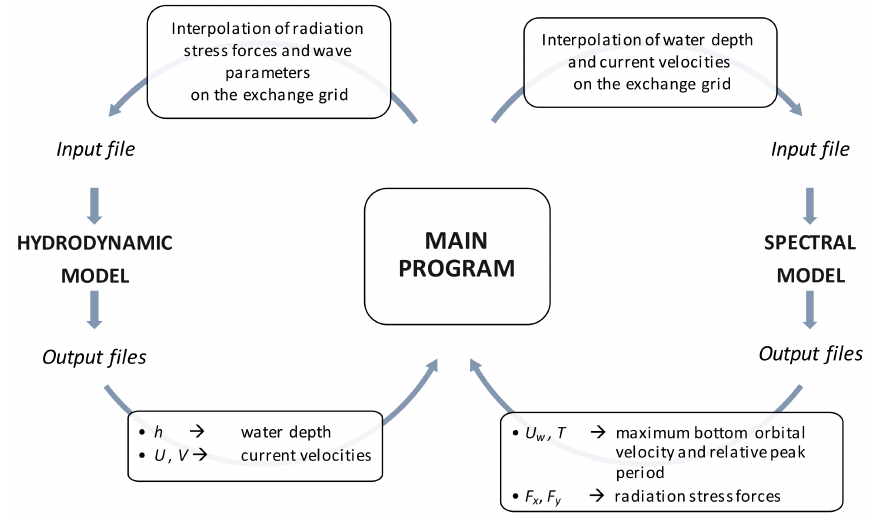
Figure 1. Flow chart of the coupling process between the hydrodynamic model and the spectral model managed by the main